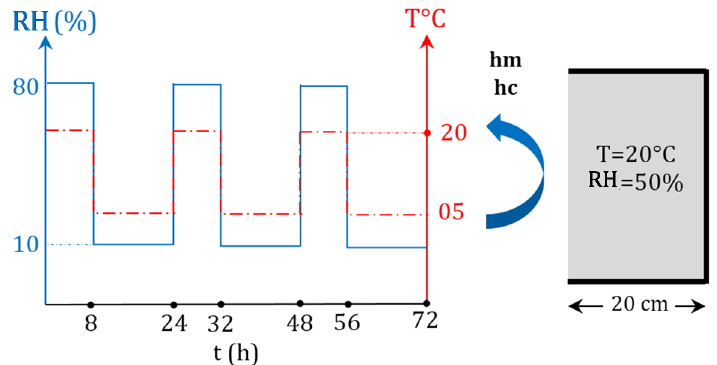
Figure 11. Dynamic climatic conditions applied in the non-isothermal case.